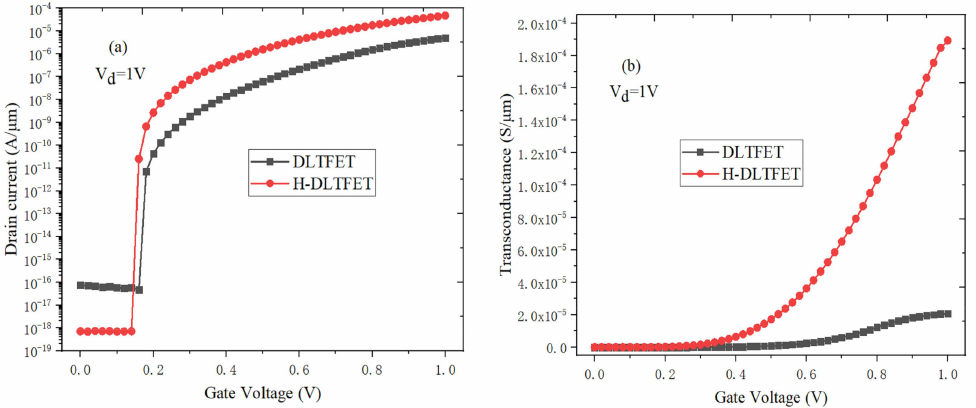
Figure 2. ( a ) Transfer characteristic, ( b ) Trans-conductance of DLTFET and